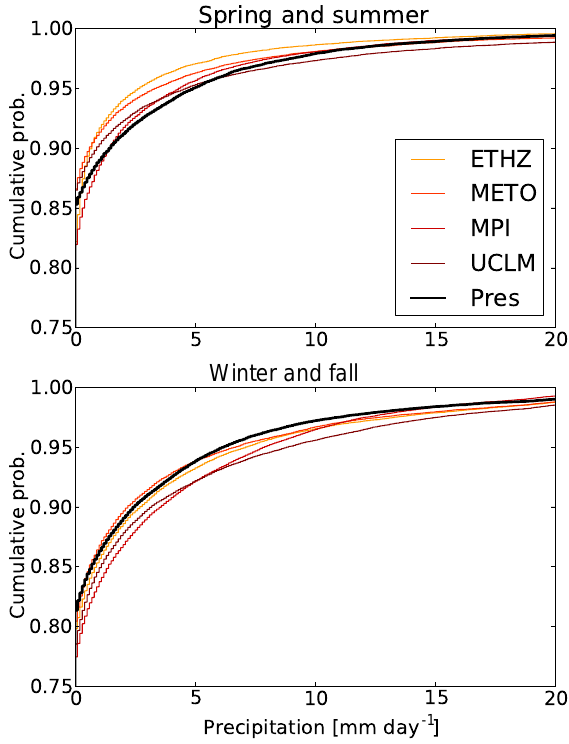
Figure 3. Empirical cumulative distribution function ( ecdf ) of drought indices based on measurement time series (in blue) and based on the outputs from the weather generator (in black). The gray area represents the boundaries of the 15 ecdf of drought in- dices based on the outputs from the weather generator when these outputs are cut at the same length as the measurement time series (23